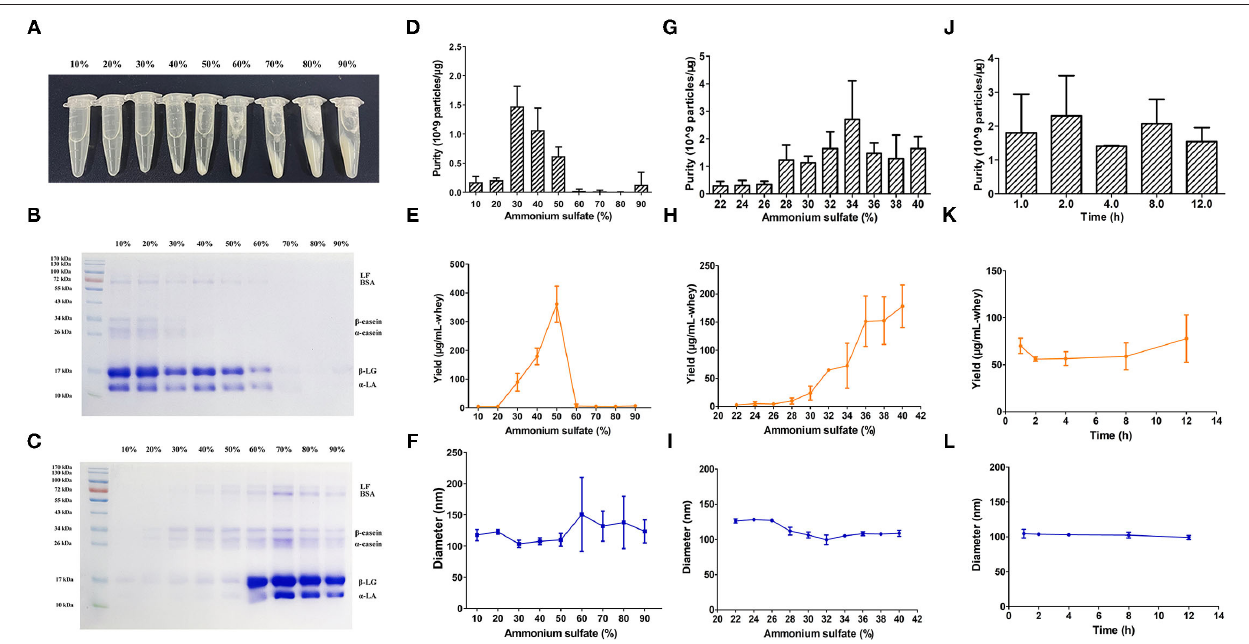
FIGURE 2 | Isolation of BM-EVs via salting-out. (A) The precipitation of whey proteins was achieved with different saturation of ammonium sulfate. The SDS-PAGE of milk proteins in the supernatant (B) and the pellets (C) following the salting-out were visualized using an image scanner. BM-EVs separated from different saturation and duration were characterized by purity (D,G,J) , yield (E,H,K) , diameter (F,I,L) . Data were presented as mean ± standard deviation ( n = 3). LF, lactoferrin; BSA, bovine serum albumin; β -LG, β -lactoglobulin; α -LA, α -lactalbumin.